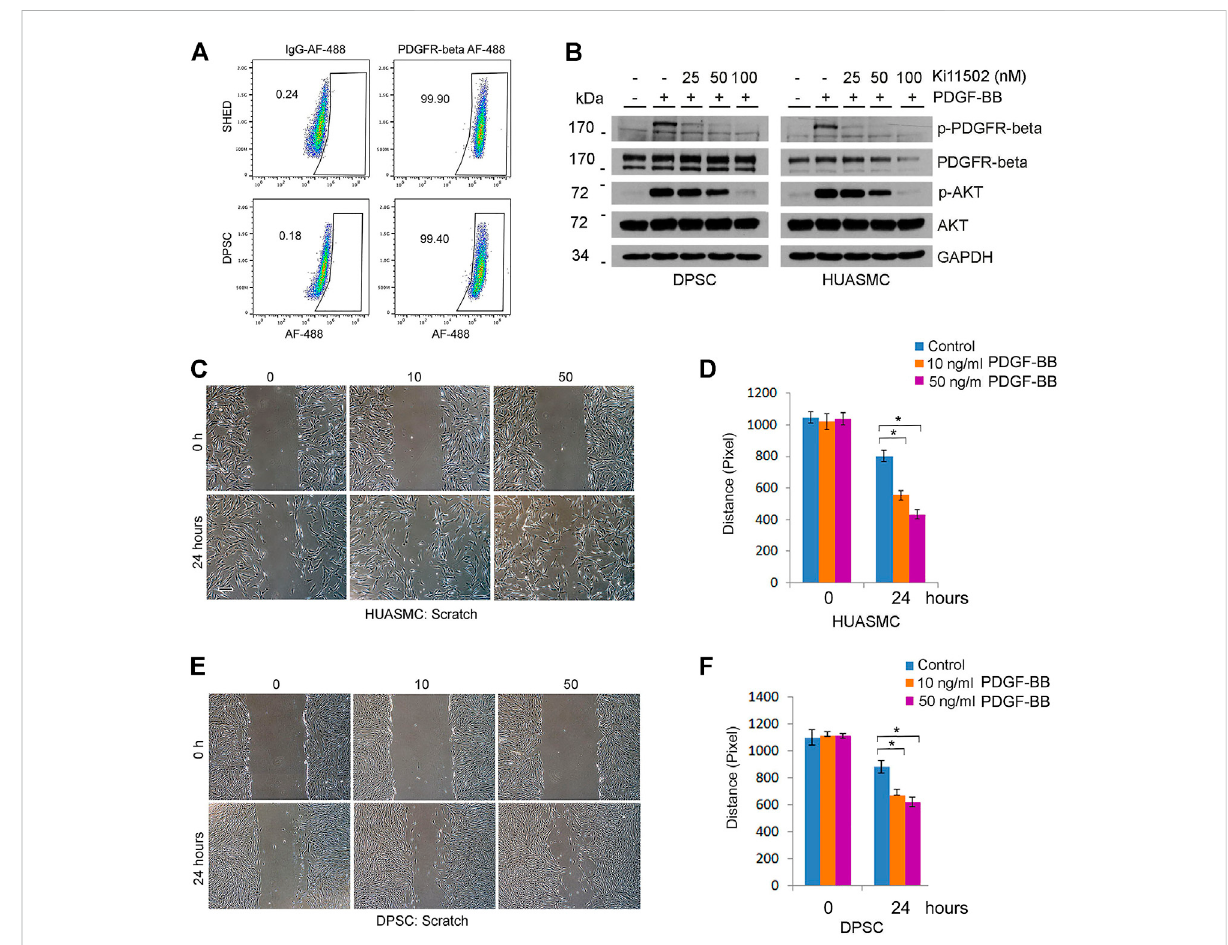
FIGURE 5 PDGFR- β signaling inducesmotilityofDPSC cellsandsmoothmusclecells invitro . (A) Flow plotsdepicting theexpressionofPDGFR- β inDPSC and SHED. IgG-AF488 was used as isotype control. (B) DPSC and HUASMC were starved overnight and pre-incubated with 0 – 100 nM Ki11502 (PDGFRinhibitor)for2 h,andthentreatedwith α -MEMsupplementedwith5%FBSinpresenceof20 ng/mlPDGF-BBfor30 min.Westernblotswere performed for p-PDGFR- β , PDGFR- β , p-AKT, and AKT. (C – F) HUASMC (C) and DPSC (E) were cultured in 6-well plates, starved overnight, scratched with a sterile 1,000 µl loading tip, then treated with α -MEM supplemented with 5% FBS in presence of 0 – 50 ng/ml PDGF-BB for indicated time points. Scale bar: 100 µm. (D,F) Graphs depicting the scratch width over time in response to PDGF-BB in HUASMC (C) and DPSC (E) . Three independent experiments using triplicate wells/experimental condition were performed to verify reproducibility of the data. Asterisk indicates p <